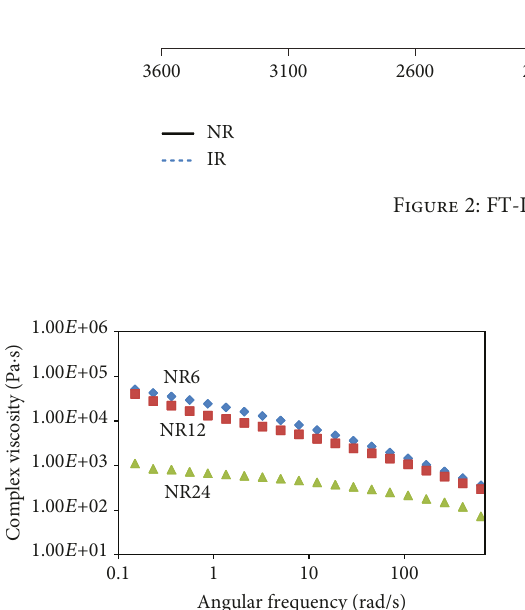
Figure 4: Complex viscosity of IR with the mastication times of 0, 6, and 12 minutes denoted by IR0, IR6, and IR12, respectively.